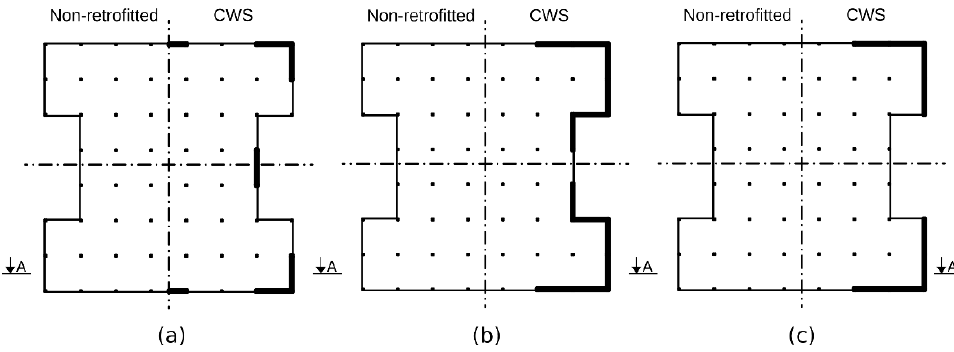
Figure 1. Floor plans of the analyzed typical building: on the right, concrete wall strengthening (Cases 1 and 2); on the left, the non-retrofitted structure (control case). ( a ) Ground floor (20 cm thick walls), ( b ) first floor (10 cm thick walls), and ( c ) floors two to four (10 cm thick walls).